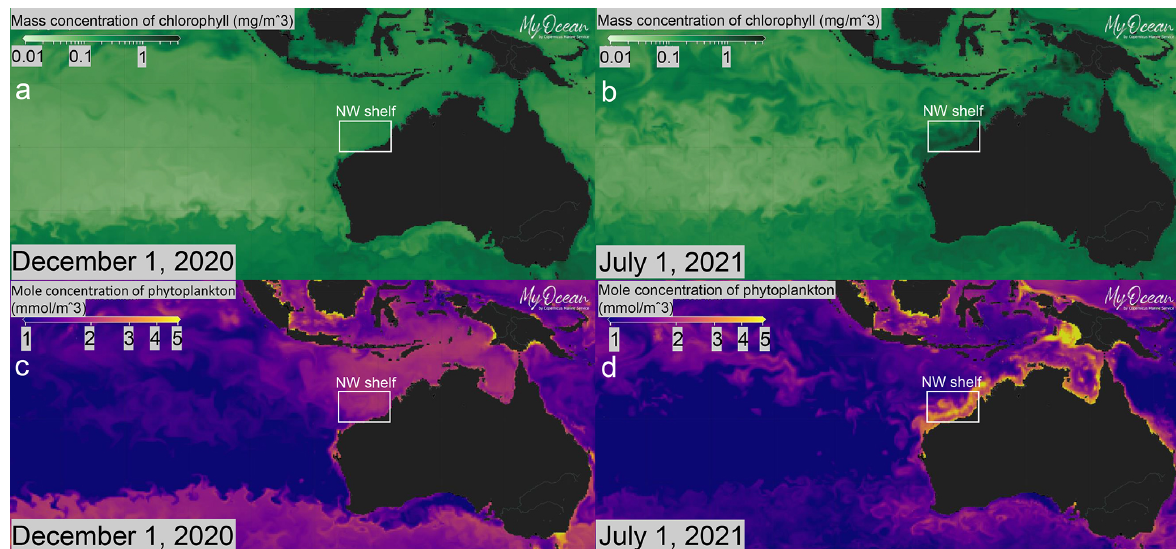
Figure 3. Present-day ocean productivity maps of the southeastern Indian Ocean area for 1 December 2020 (austral summer; a , c ) and 1 July 2021 (austral winter; b , d ). The reduced LC and increased water column stratification during austral summer lead to low concentrations of (a) chlorophyll and (c) phytoplankton in the NW Australian shelf area. Intense LC and storm track activity during austral winter leads to increased water column mixing in the NW Australian shelf and significantly higher (b) chlorophyll and (d) phytoplankton concentrations. Maps were generated using the ocean data visualisation tools of EU Copernicus Marine Service Information (MyOcean Pro) and the dataset layer GLOBAL_ANALYSIS_FORECAST_BIO_001_028 (https://doi.org/10.48670/moi-00015).